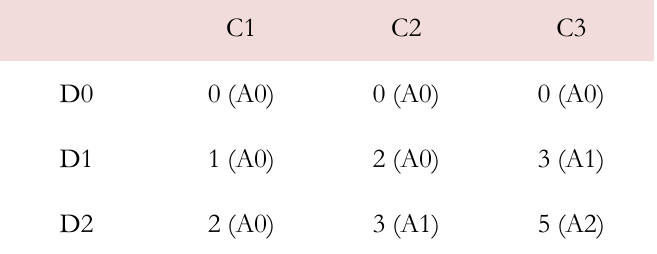
Table 6: Table of the scores and the maintenance level (in square brackets) attributed to each entry of the check lists reported in Tabs. 3 and 4, depending on the level of damage and the class of